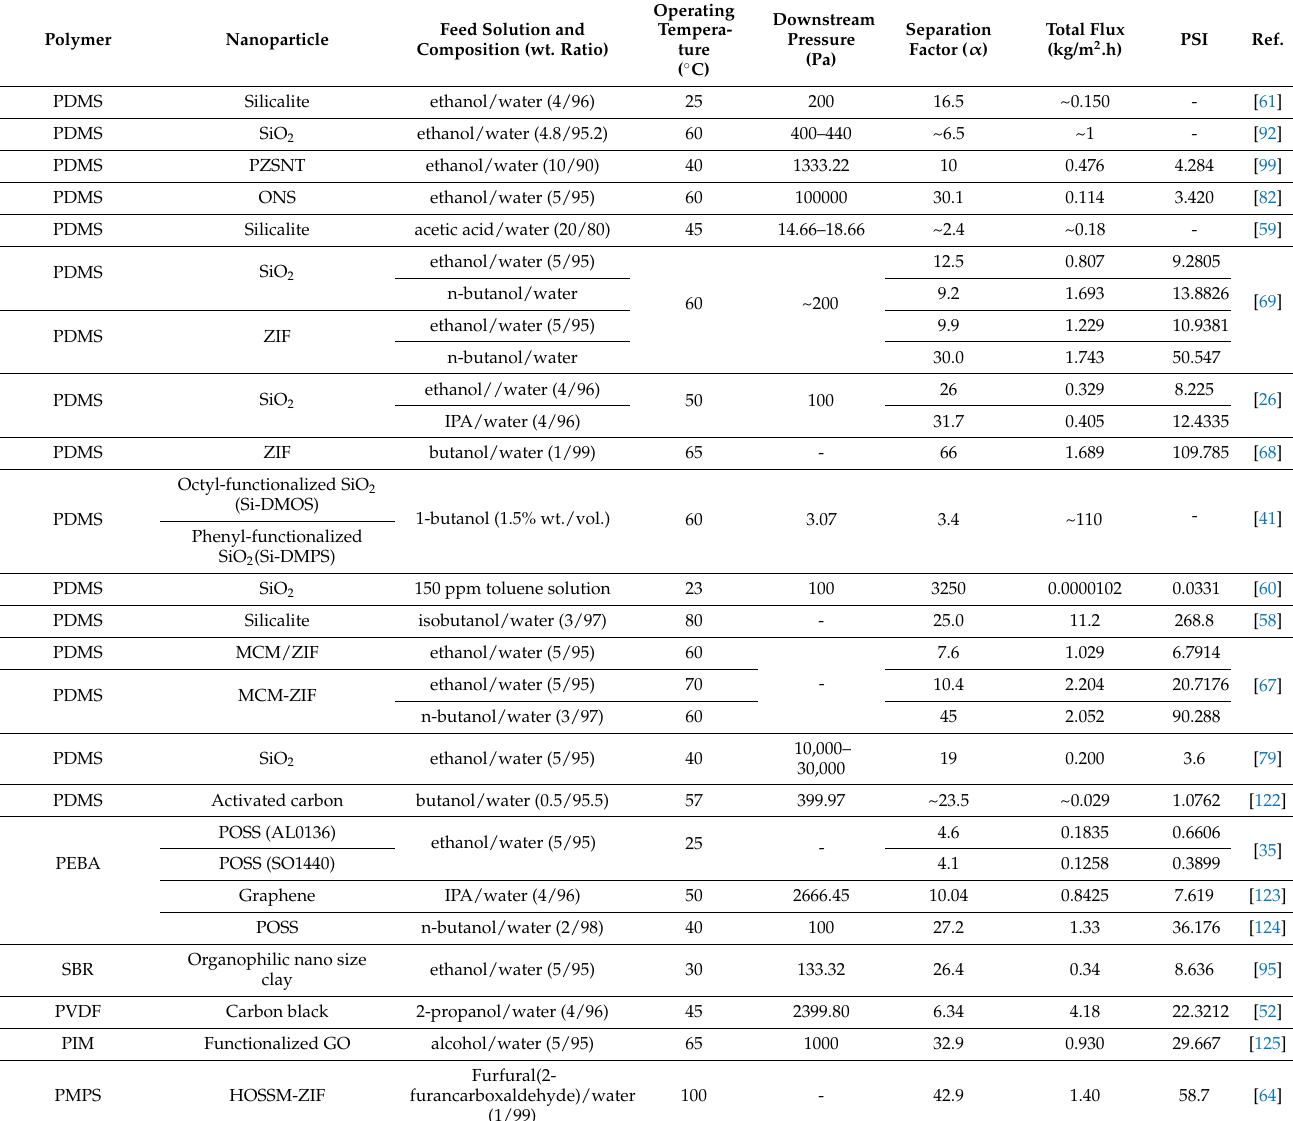
Table 8. PV performance of hydrophobic nanocomposite